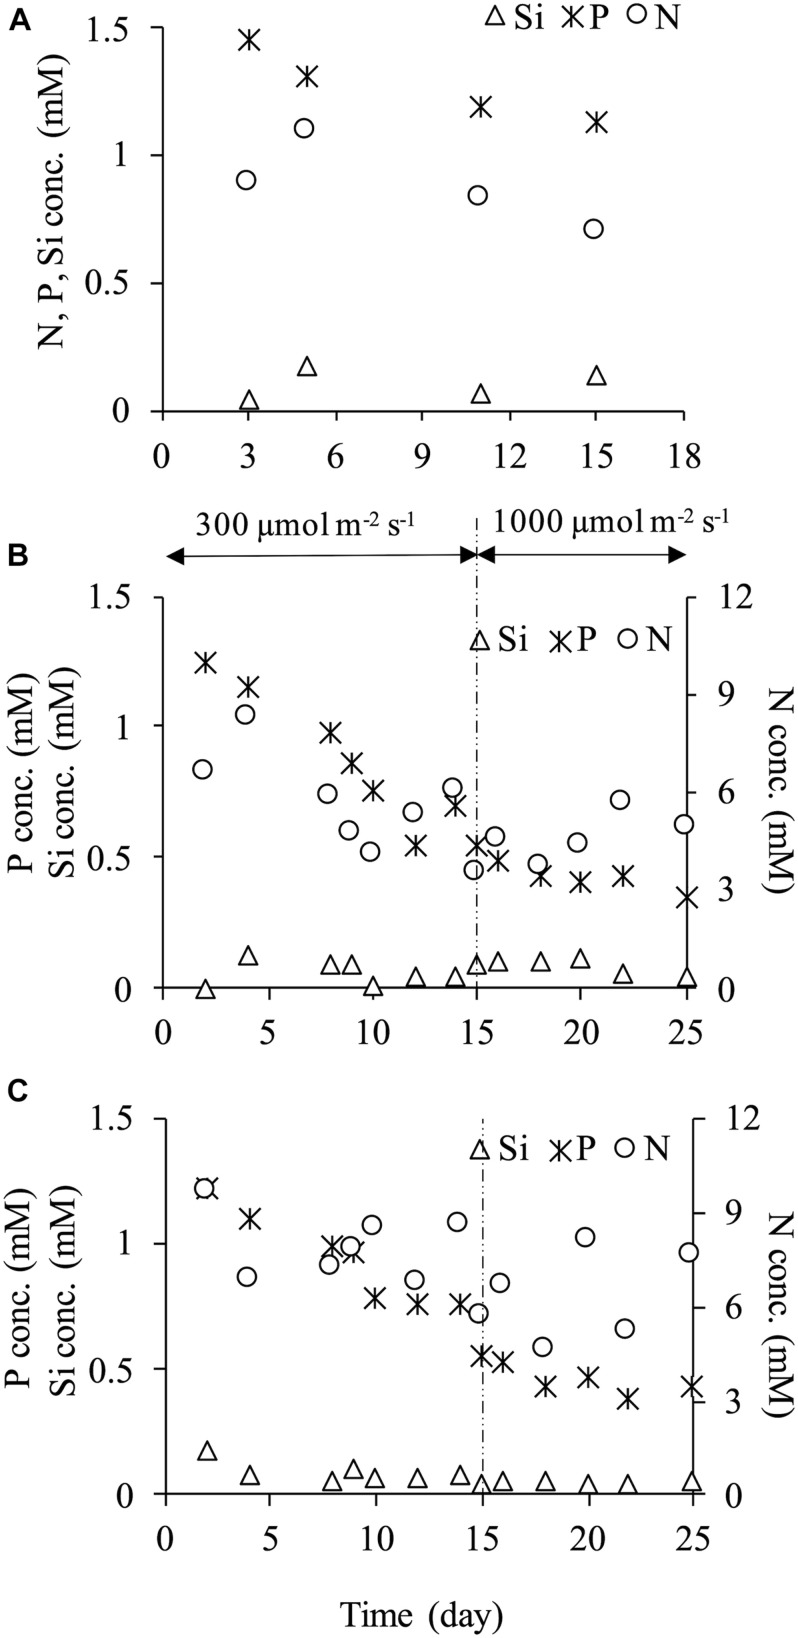
Nutrients concentration (NO3-N, PO4-P, SiO2-Si) at dilution rate of 0.1 d–1
(A), 0.2 d–1
(B) and 0.4 d–1
(C).